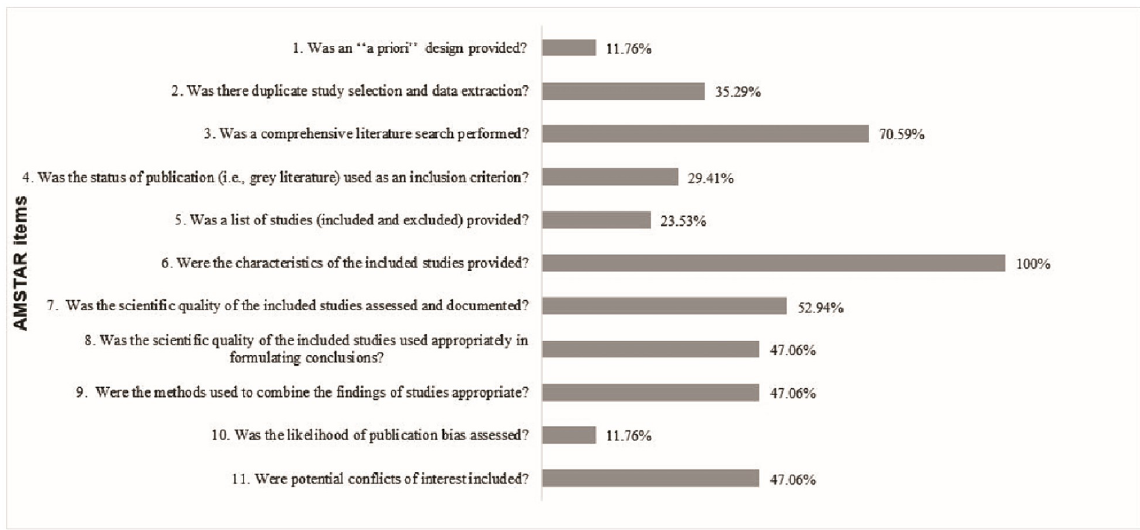
Fig 2. Percentage of systematic reviews that appropriately address each (AMSTAR)